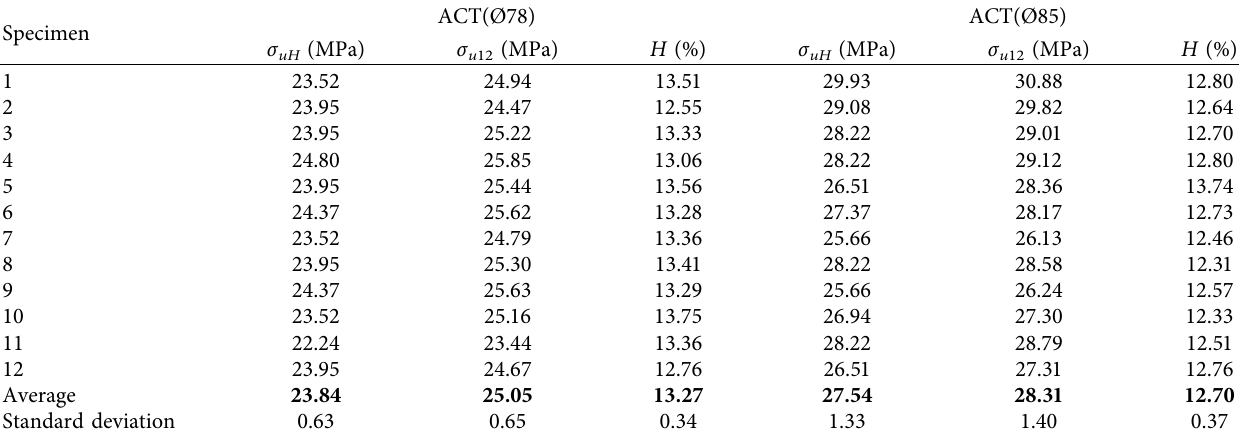
Table 9: Tangential compressive failure stresses, diameters 78cm and 85cm.